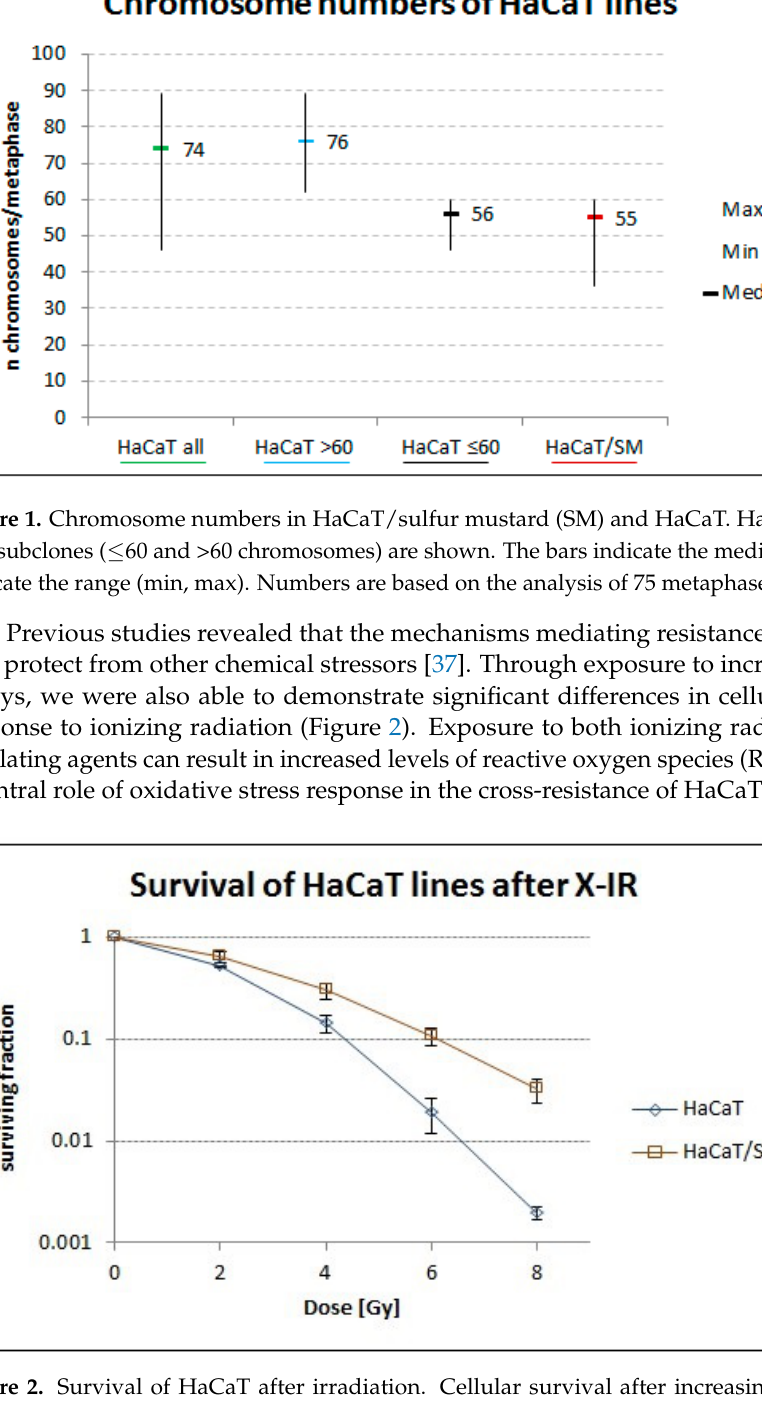
ionizing radiation (IR) shows a radioresistant phenotype of the HaCaT/SM cell line, especially at